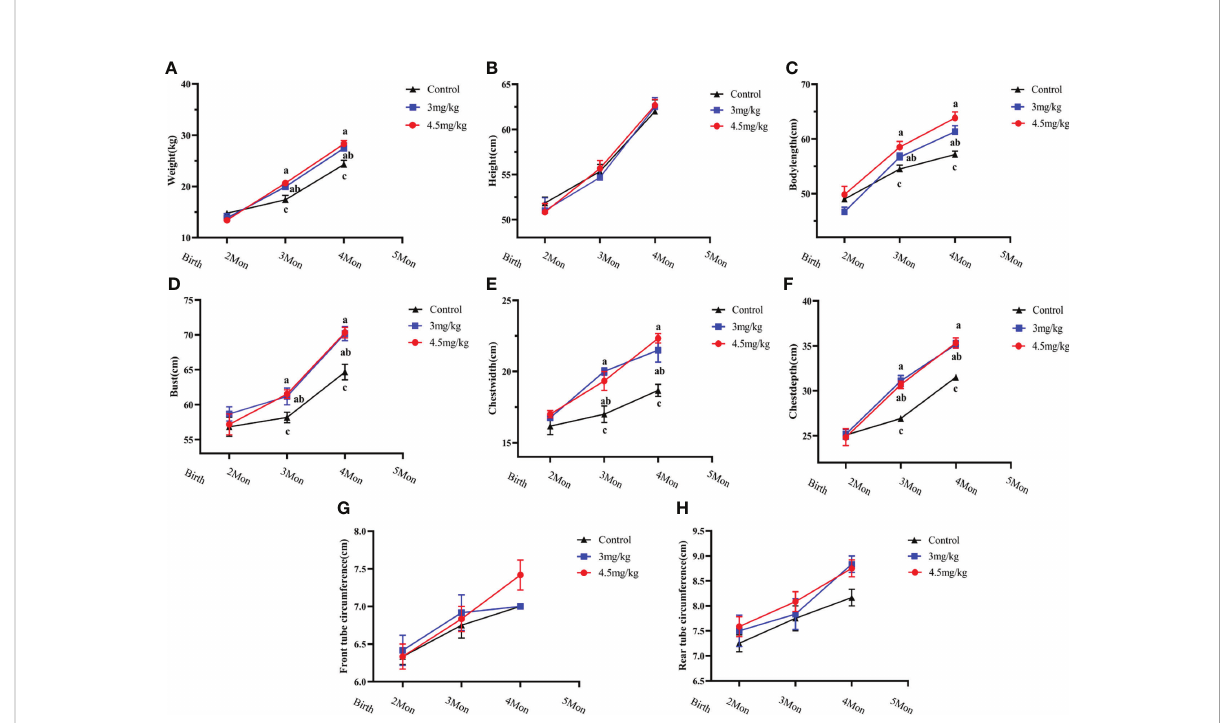
FIGURE 1 Effects of melatonin on growth performance of lambs. (A) body weight; (B) body height; (C) body oblique length; (D) chest circumference; (E) chest width; (F) chest width; (G) anterior tube circumference; (H) posterior tube circumference Different letters indicate P <0.05 vs